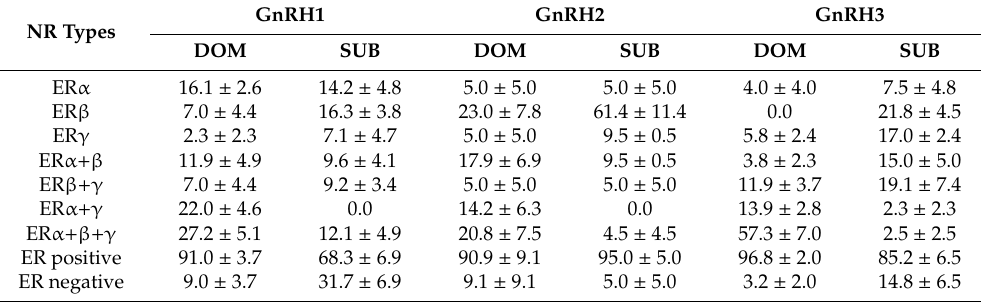
Table 1. Percentages of GnRH neuron types with single or multiple nuclear receptor mRNA transcripts in dominant (DOM) and subordinate (SUB) males ( n = 8 each).